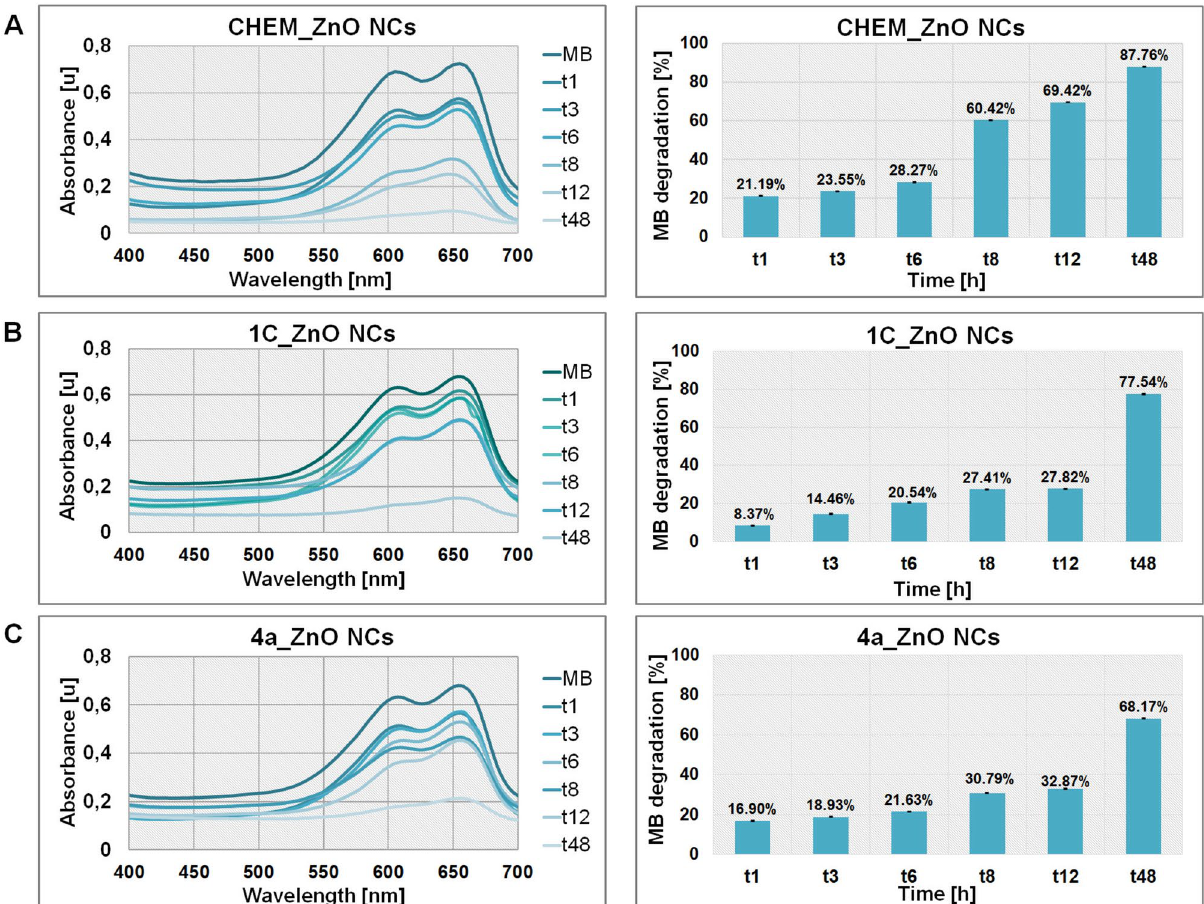
Figure 9. The UV–vis plot and efficiency of MB photocatalytic degradation (%) after CHEM_ZnO NCs ( A ), 1C_ZnO NCs ( B ) and 4a_ZnO NCs ( C )